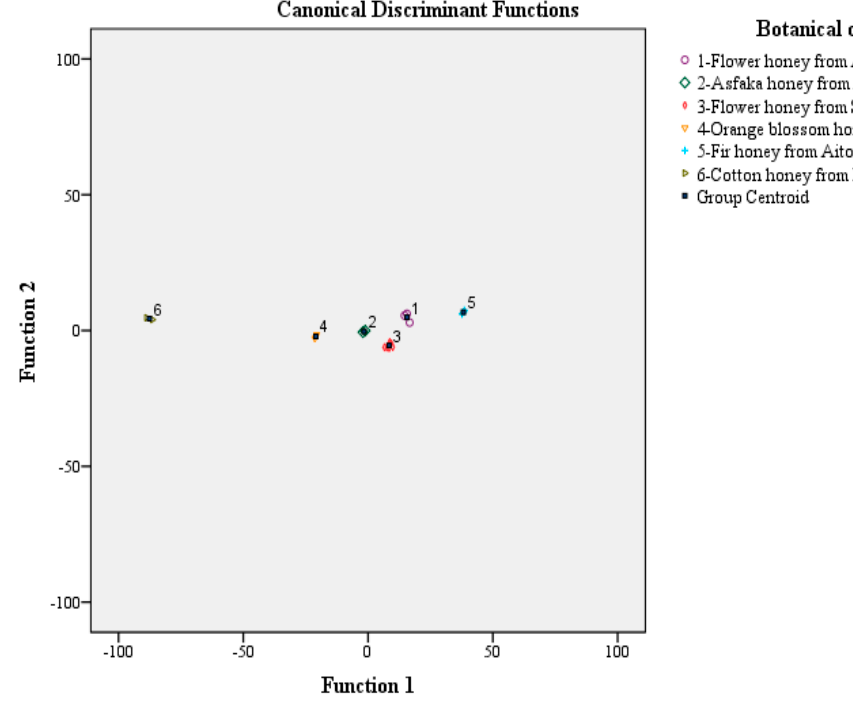
Figure 1. Botanical origin differentiation of Hellenic asfaka, cotton, flower, fir, forest flowers and orange blossom honeys based on abundant mineral and total mineral contents and stepwise discriminant analysis.